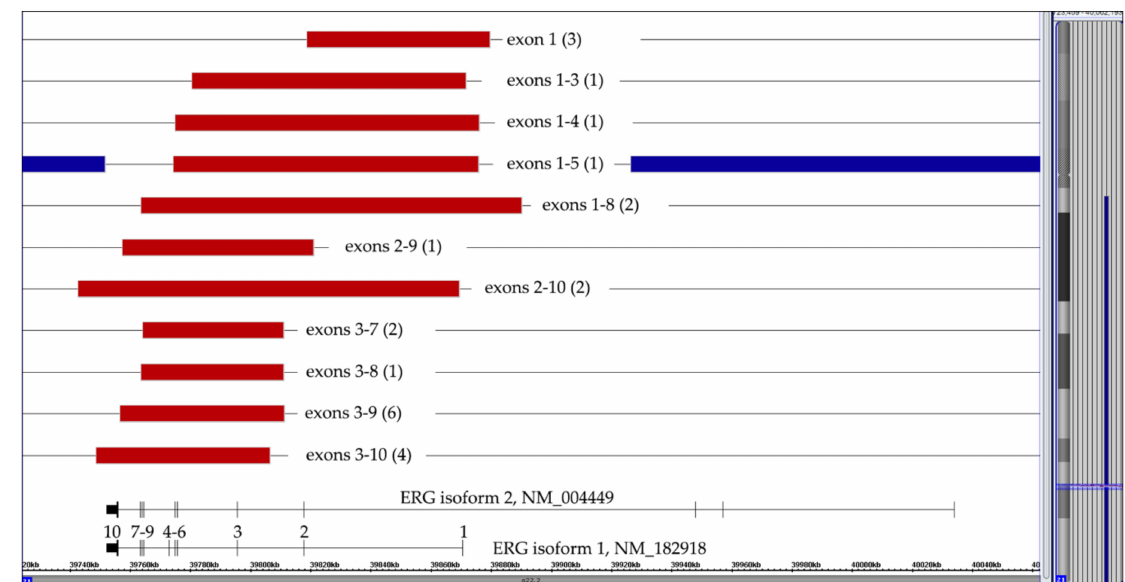
Figure 5. Summary of 24 cases with eleven different types of isoform 1-projected ERG deletions. The numbers of the respective cases are in brackets. Since the exon 1–5 deletion in the case with a trisomy 21 (represented by the blue lines) affected two alleles, the deletion must have already taken place before the chromosome